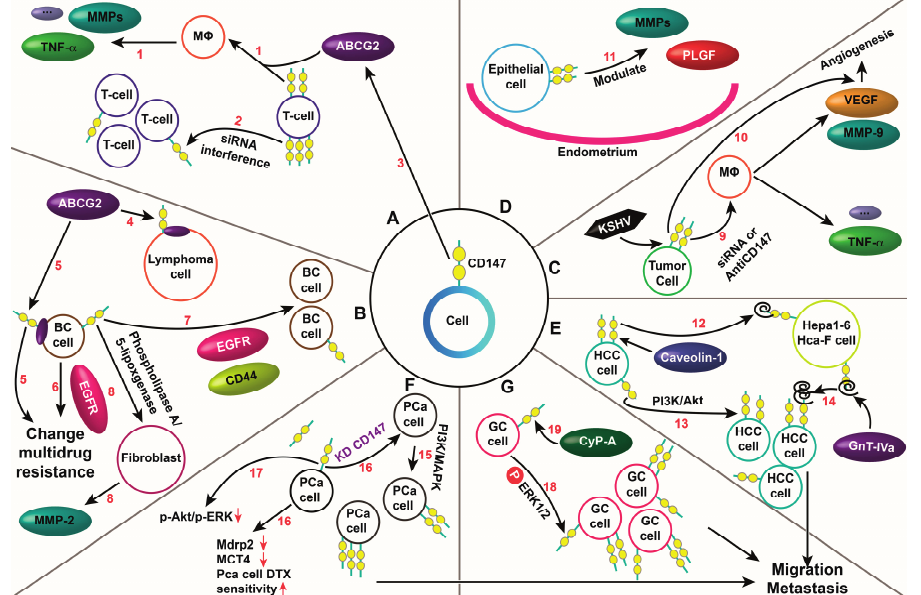
Figure 2. CD147 plays an important role in a variety of cells and tissues regardless of health or disease. ( A ) T cell-mediated immune response; (1) The regulatory role of CD147; (2) The “negative” regulatory role of CD147 as shown by CD147 knockdown (KD), leading to increased T cell proliferation; (3) CD147 regulates the ABCG2-driven transport of methotrexate; ( B ) Regulating the expression, dimerization and drug transporter function of ABCG2; (4) CD147–ABCG2 complex on the lymphoma cell membrane; (5) CD147 and ABCG2 mediate multidrug resistance in breast cancer (BC); (6) EGFR promotes multidrug resistance; (7) CD147, CD44 and EGFR signaling pathways cooperate to regulate invasiveness; (8) The phospholipase A - and 5-lipoxygenase-catalyzed pathway 2 and CD147 stimulate fibroblast MMP-2 release; ( C ) Tumor cell-M φ interactions promote angiogenesis; (9) CD147 enhances the monocytic secretion of MMP-9 and VEGF, while inhibition of its expression decreases the induction of these two pro-angiogenic proteins; (10) KSHV activation of CD147 induces P13K/Akt- and MAPK-dependent secretion of VEGF; ( D ) The effects of CD147 on trophoblastic function; (11) Under progesterone-rich conditions, CD147 regulates MMPs and PLGF during gestation; ( E ) Regulating the proliferation, anoikis, migration and metastasis of HCCs; (12) Caveolin-1 promotes HCC invasion by up-regulating the glycosylation of CD147; (13) CD147 mediates resistance to anoikis in HCC cells by activating the PI3K/Akt pathway; (14) The key role of GnT–IVa in the migration and metastasis of HCCs involves alteration of the antennary oligosaccharide structures on glycosylated CD147; ( F ) Regulating the metastasis and chemoresistance of PCa cells; (15) CD147 expression is mediated by the PI3K and MAPK pathways; (16) CD147 KD decreases MCT4 and multi-drug resistance protein-2(Mdrp2) expression and reduces the invasive potential and proliferation of PCa while enhancing docetaxel sensitivity; (17) CD147 KD down-regulates p-Akt and p-Erk, the main signal modulators associated with cell growth and survival; ( G ) Regulating the migration and metastasis of GCs; (18) The ERK1/2 signaling pathway is involved in CD147-mediated proliferation and invasion of gastric cancer cells; (19) Extracellular Cyp-A stimulates ERK1/2